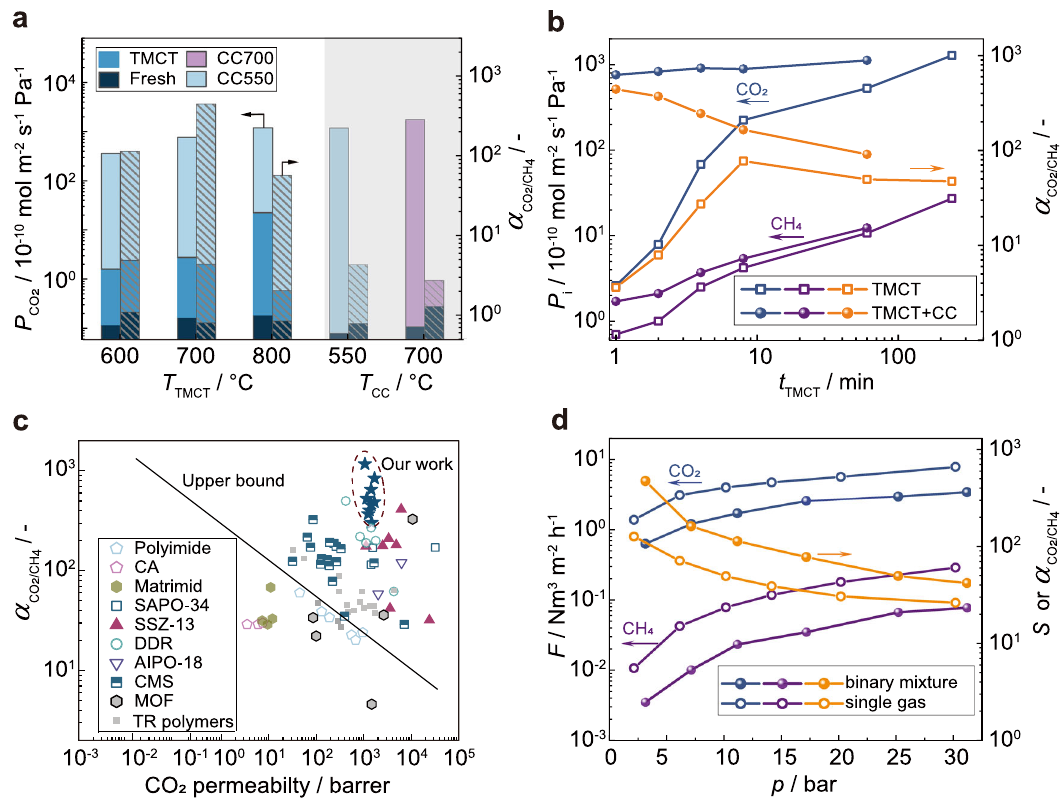
Fig. 5 TMCT procedure optimization and CO 2 /CH 4 separation performance. a Investigation on TMCT (one-minute overheating) temperature and CO 2 / CH 4 separation performance comparison with the membranes detemplated by conventional calcination at 550 °C (CC550) and 700 °C (CC700). b Effect of TMCT period on CO 2 /CH 4 separation performance. c Comparison on CO 2 /CH 4 separation performance, involving commercial cellulose acetate (CA) membranes 31 , polyimide membranes 29 , Matrimid membranes 30 , carbon molecular sieve (CMS) membranes 35 – 37 , MOF membranes 38 – 40 , and other 8MR zeolite membranes 28,32 – 34,52 . d Gas permeation fl ux ( F ) and CO 2 /CH 4 selectivity of 20 cm hollow fi ber DD3R zeolite membrane in pure components (open symbols) and equimolar mixture (solid symbols) with pressure range of 3 to 31 bar (condition: room temperature, without sweep gas). Source data are provided as a Source Data fi